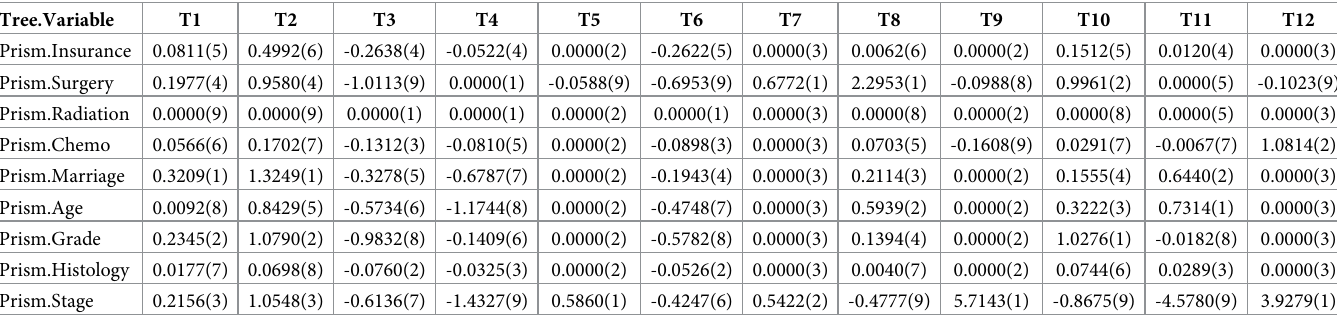
Table 5. Local variable importance measure for the PRISM tree. T1, ... , T12 indicate terminal node number.